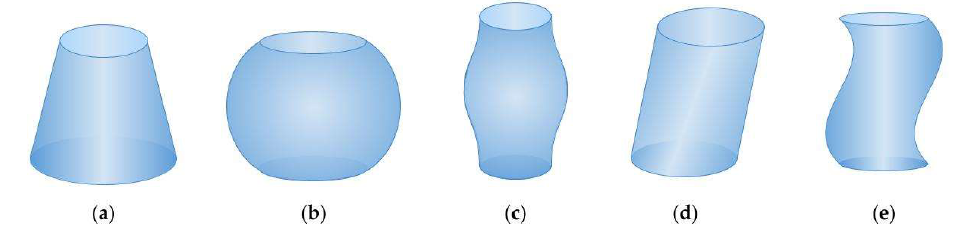
Figure 1. Channel patterns: ( a ) frustum, ( b ) truncated sphere, ( c ) tube with sinusoidal gradually-varying radius, ( d ) tilted cylinder, and ( e ) tube with sinusoidal non-varying radius.